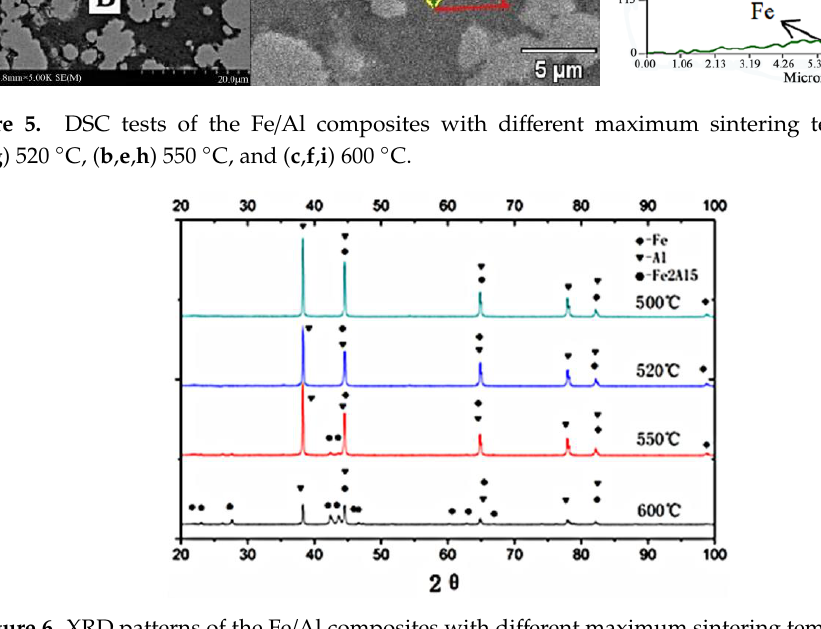
Figure 6. XRD patterns of the Fe/Al composites with different maximum sintering temperatures.